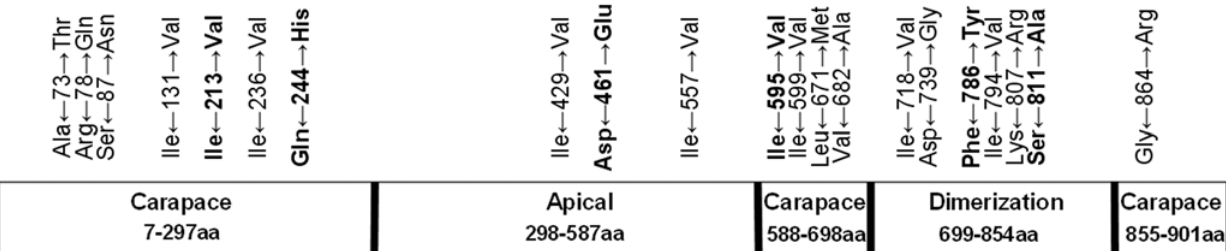
Figure 2. Schematic representation of VP3, showing the location of parsimony-informative sites found among viral isolates. The three domains of VP3 (apical, carapace, and dimerization) according to Grimes et al., (1998) are indicated. Positions 213, 244, 461, 595, 786, and 811 that are conserved within each lineage are indicated in bold and correspond to Ile, Gln, Asp, Ile, Phe, Ser for the ‘west’ lineage and Val, His, Glu, Val, Tyr, Ala for the ‘east’.